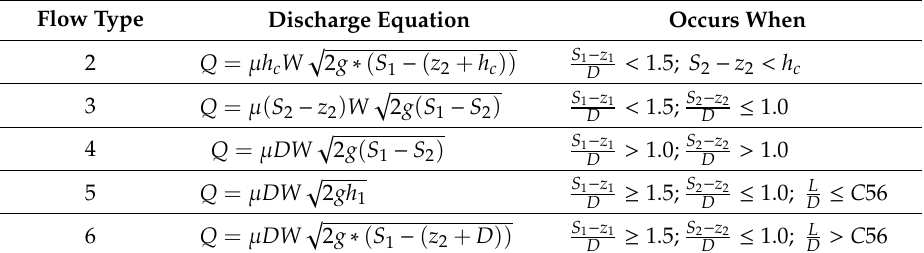
Table 2. Summary of the discharge equations for the di ff erent flow types through a culvert following Carlier